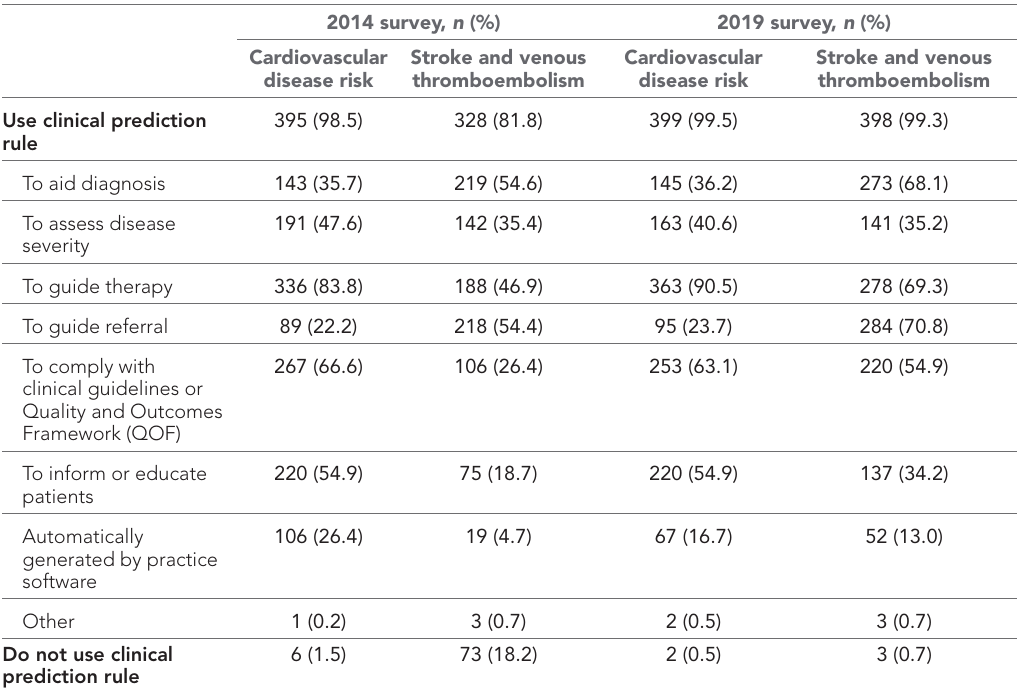
Table 5 GPs reporting respective reasons for using clinical prediction rules, N = 401 2014 survey, n (%) 2019 survey, n